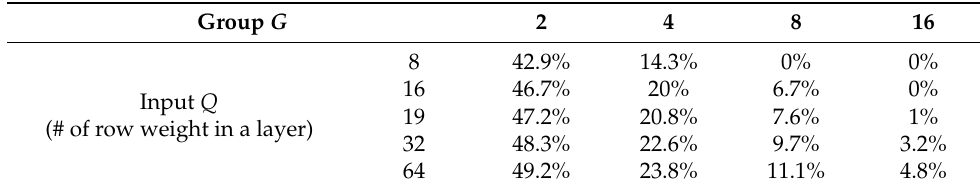
Table 2. Error probability of probabilistic second minimum for different groups and inputs. Group